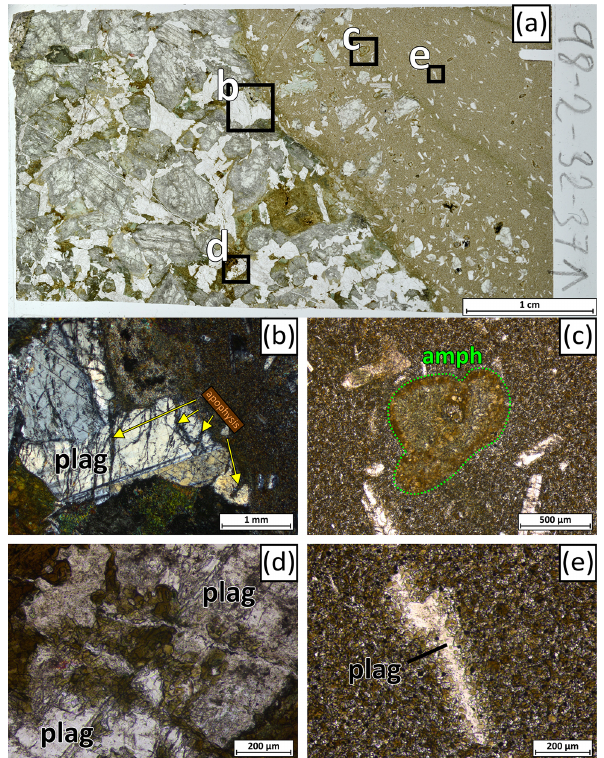
Figure 5. (a) Thin-section photo of sample GT3A-98Z-2, 32– 37cm, showing the contact between a varitextured gabbro and a basalt. Both lithologies show a high-temperature granoblastic over- print due to contact metamorphism resulting from an uprising AML. For details see text. The marked boxes represent details shown in (b) to (e) ; plane-polarized light. (b) Apophyses of former basaltic melt penetrating plagioclase of the gabbro at the contact; cross-polarized light. (c) Cluster of granoblastic amphibole (amph) replacing for- mer alteration phases; plane-polarized light. (d, e) Cluster of amphi- bole overgrowth as record of high-temperature granoblastic over- print both in the gabbro (infiltrating a plagioclase crystal) and in the basaltic matrix (surrounding a plagioclase xenocryst); plane- polarized light.